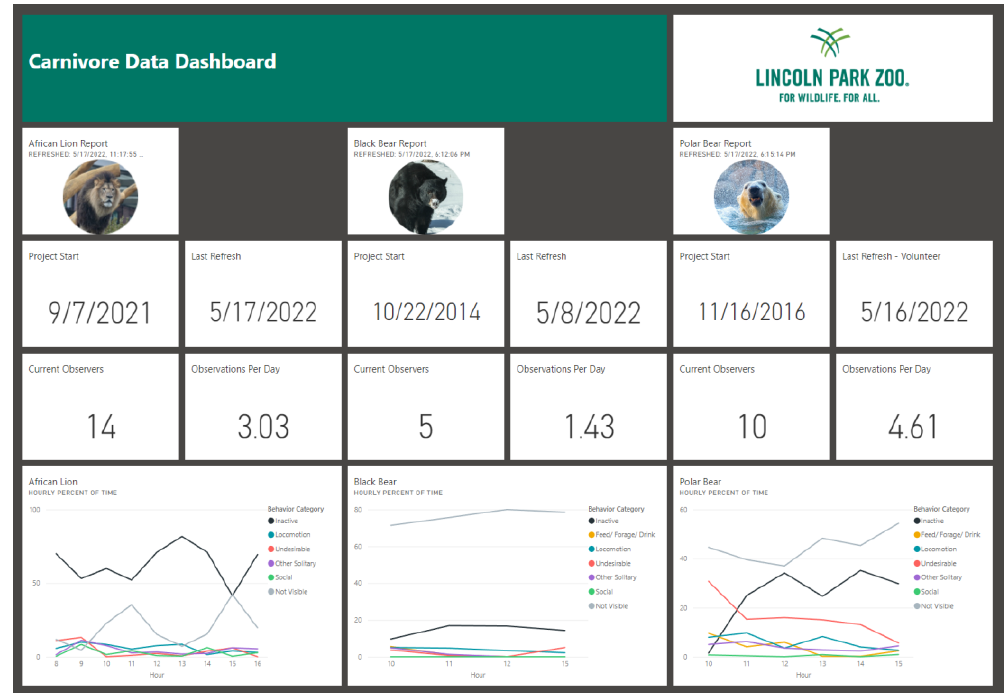
Figure 3. An example screenshot of a dashboard in the Microsoft Power BI software.